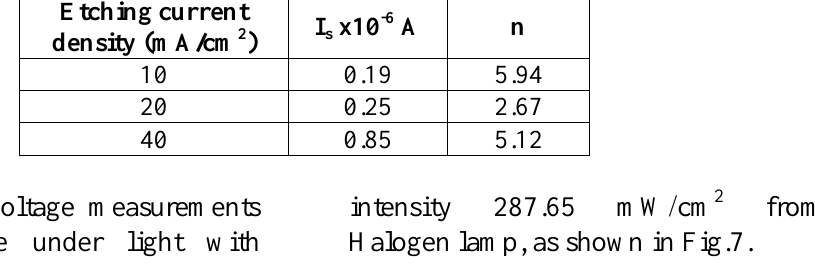
Fig. 6: Variation of Ln(J/J ) vs. bias voltage to extract ideality factor. s Table4: I and n for p-PS at different etching current densities in dark. s